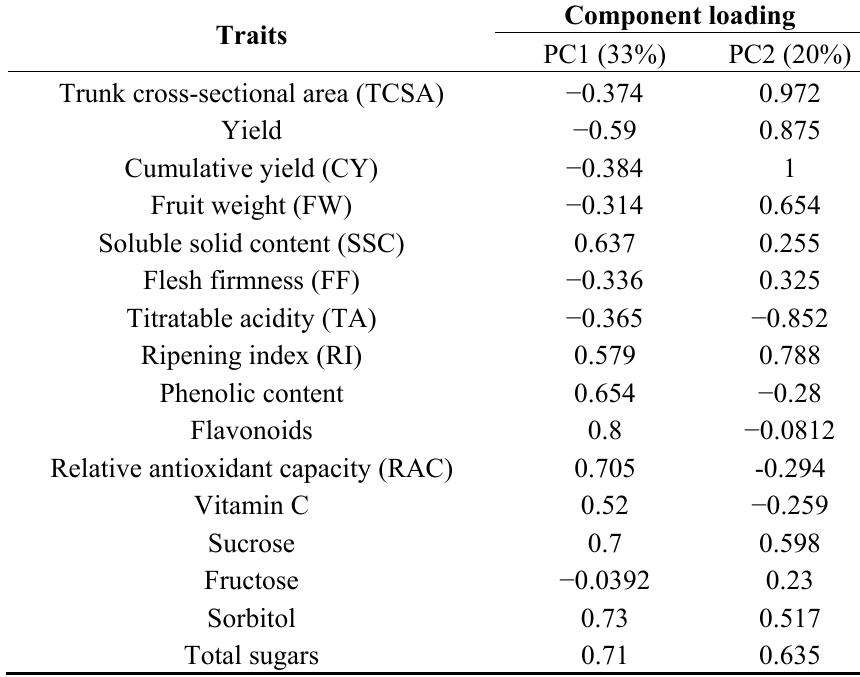
Table 6. Eigenvectors of the principal component analysis (PCA) axes of the agronomical, basic fruit quality and phytochemical traits evaluated on different plum rootstocks budded with “Catherine”